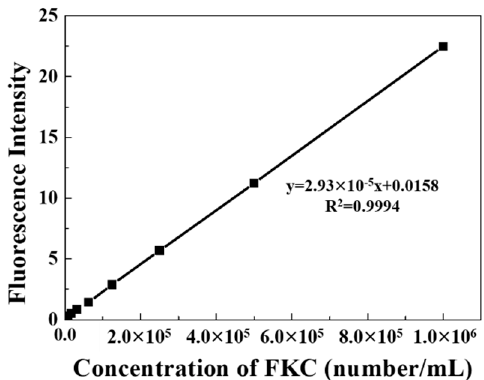
Figure 6. Linear regression result for FITC- labelled FKC concentration (number / mL) and fluorescence intensity at 520 nm.